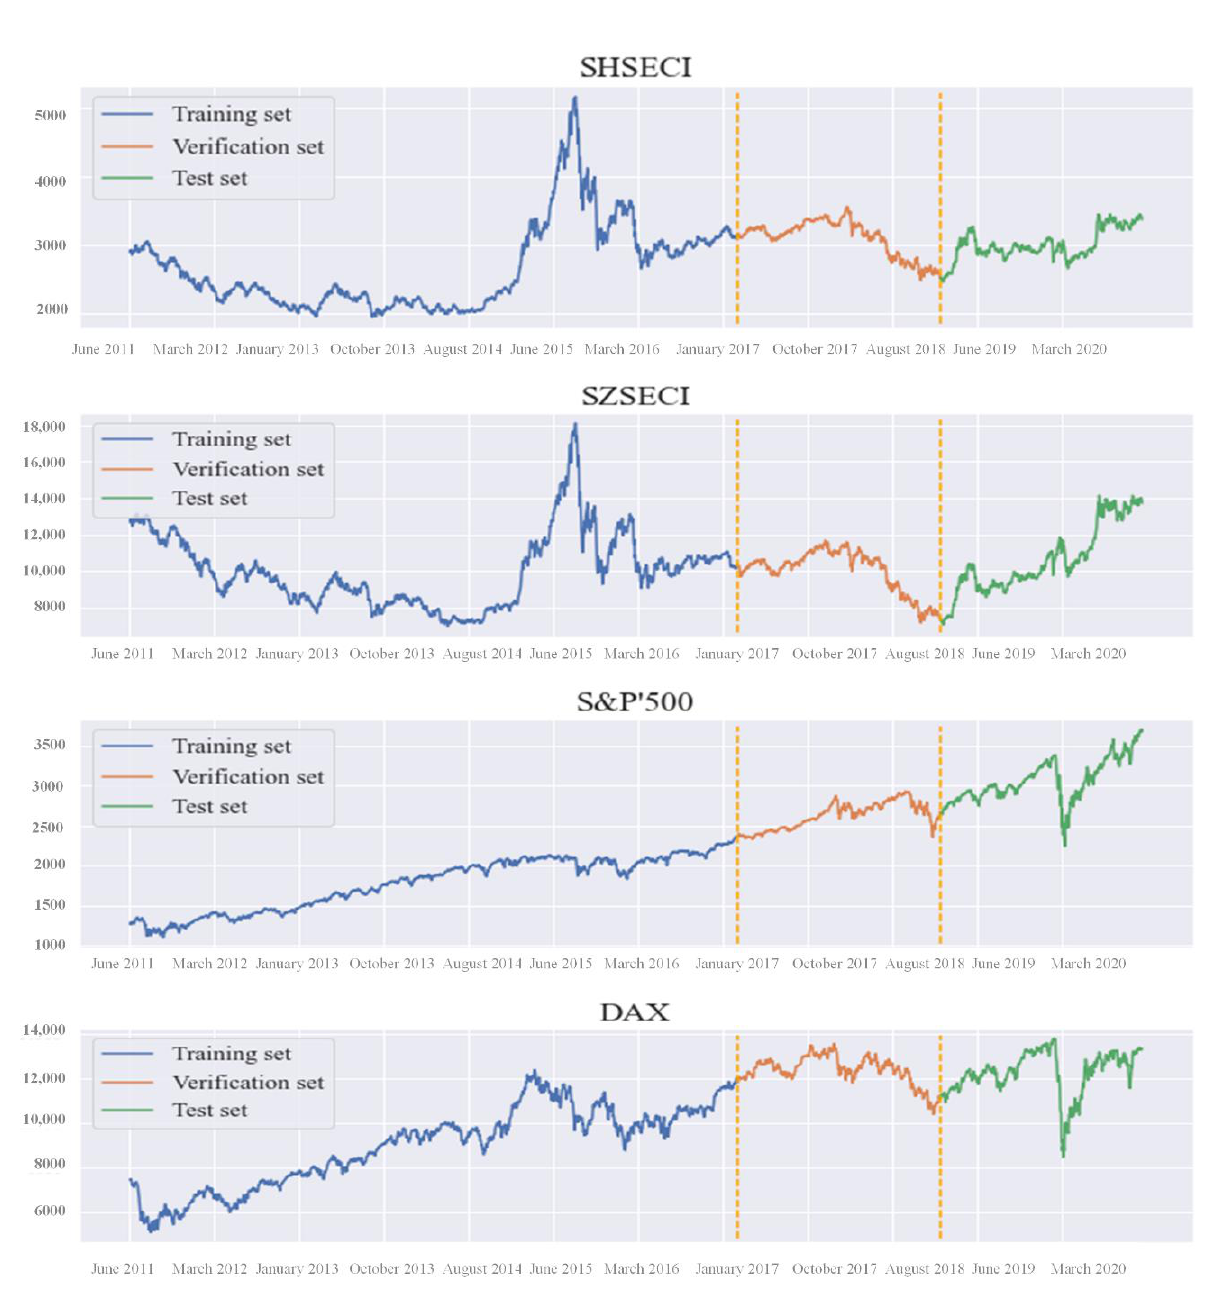
Figure 3 . Data resources. Figure 3. Data